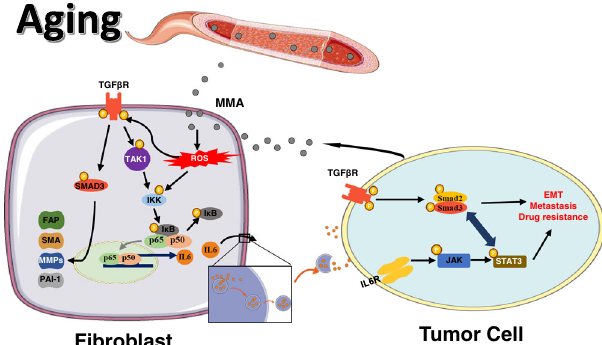
Fig. 6 | MMA activates fi broblasts and induces their EV-associated IL-6 secre- tion,whichdrivesmetastaticreprogrammingintumorcells. MMAproducedby tumorcellsinducesgenerationofROSin fi broblasts.ROSactivatesTGF β signaling, which promotes expression of CAF markers, and NF- κ B signaling, which promotes IL-6 loading into and secretion through EVs. EVs loaded with IL-6 activate STAT3signalingandTGF β signalingintumorcells,promotingEMT,drugresistance and